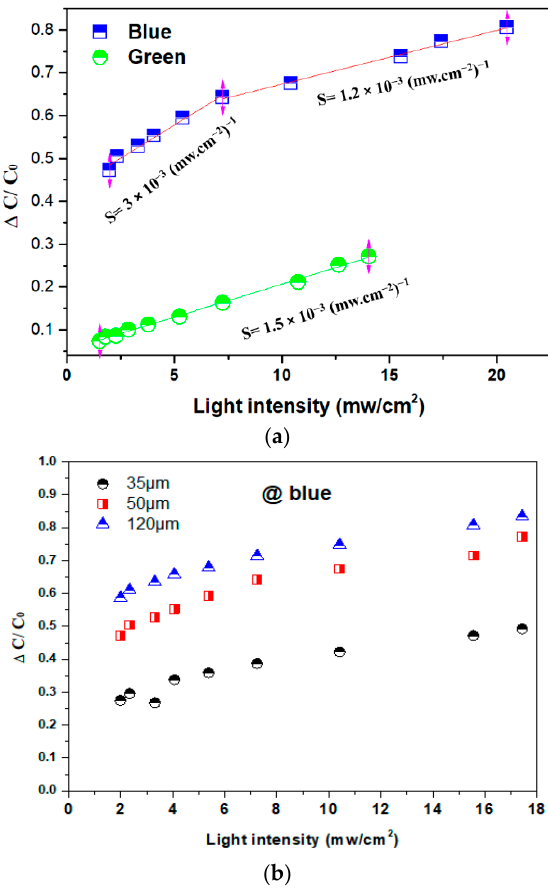
Figure 5. ( a ) Capacitance change versus light intensity with: ( a ) blue and green LEDs and, ( b ) only blue LED with different thicknesses of polymer composites.